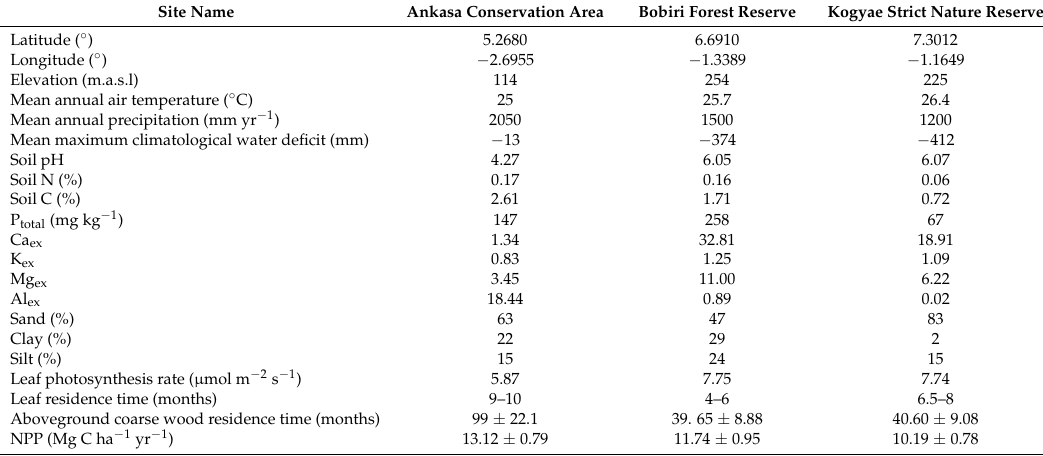
Table 1. Meteorological, soil and productivity characteristics for the 3 tropical forest study sites located along a 1200–2000 mm rainfall gradient in Ghana. P total = total soil phosphorus pool. Ca ex , Mg ex , K ex , Na ex , Al ex = exchangeable calcium, magnesium, potassium and aluminum concentrations. ± 1 standard deviation. Adapted from Moore et al. [52]. See Moore et al. [52] and Gvozdevaite et al. [54] for more details. Site Name Ankasa Conservation Area Bobiri Forest Reserve Kogyae Strict Nature Reserve Latitude ( ◦